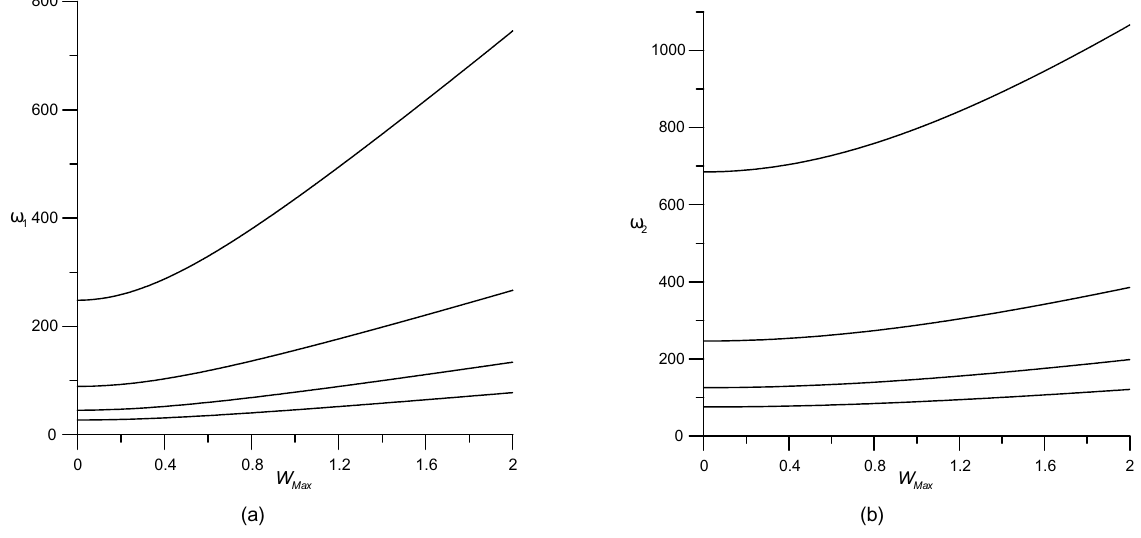
Fig. 3. The first (a) and second (b) natural frequencies of the plate as functions of the maximum nondimensional deflection W Max for clamped-clamped plates of inner radii b = 0 . 1 , 0 . 3 , 0 . 5 , and 0 . 7 . Simply supported ( sliding ) -clamped